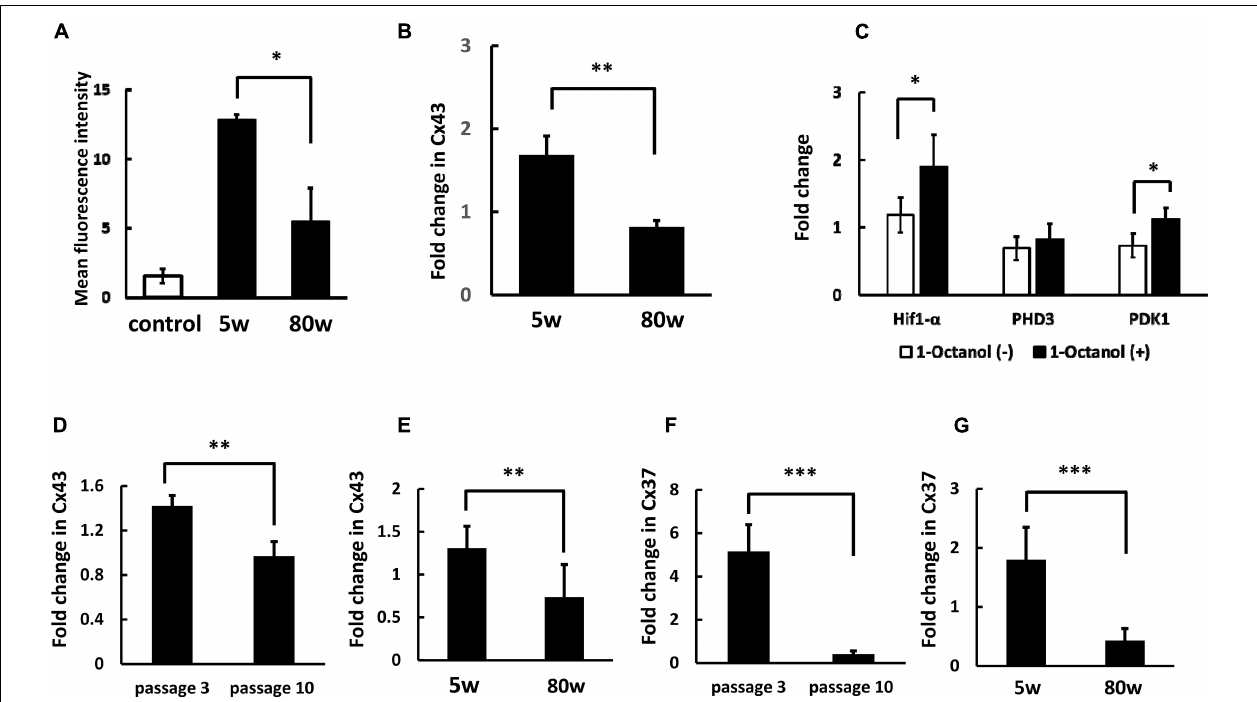
FIGURE 2 | Decreased cell-cell interaction between endothelial cells and WBC of aged mice. (A) Transfer of low molecular weight molecule (BCECF) from WBC to HUVEC significantly decreased at WBC of aged mice, compared with young mice. Control indicates background fluorescence level HUVEC without co-incubation of WBC. (B) The RNA transcription of Cx43 in WBC was significantly decreased with aging. (C) Blockade of cell-cell interaction between WBC and HUVEC via gap junction increased the expression of Hif1- α and PDK1 in WBC. (D) The RNA transcription of Cx43 in HUVEC was significantly decreased with passaging. (E) The RNA transcription of Cx43 at hippocampus was significantly decreased with aging. (F) The RNA transcription of Cx37 in HUVEC was significantly decreased with passaging. (G) The RNA transcription of Cx37 at hippocampus was significantly decreased with aging. ∗ p < 0.05 versus 5W ( N = 5 in group A ), ∗∗ p < 0.01 versus 5W ( N = 6 in group B ) by Student’s t -test. ∗ p < 0.05 versus 1-Octanol (–) ( N = 4 in group C ). ∗∗ p < 0.01, ∗∗∗ p < 0.001 versus passage 3 ( N = 4 in group D, F ) by Student’s t -test. ∗∗ p <0.01, ∗∗∗ p < 0.001 versus 5W ( N = 7 in group E, G ) by Student’s t